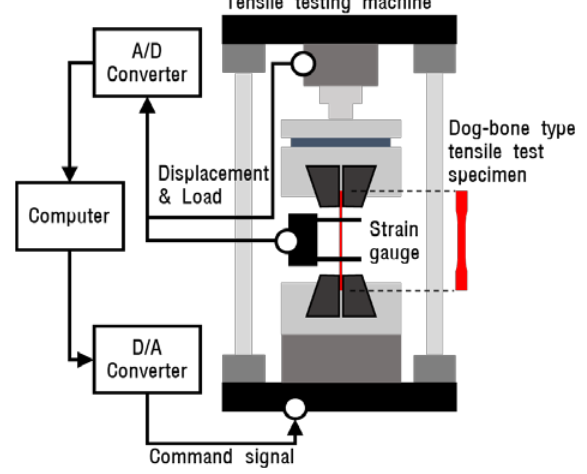
Figure 2. Schematic of tensile test.